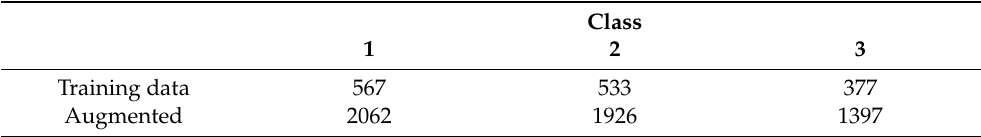
Figure 1. Representative examples of mammograms in MLO projection illustrating the 3 defined classes: ( 1 ) “breast tissue”, ( 2 ) “benign lymph nodes”, and ( 3 ) “suspicious lymph nodes”, with magnification of the ROI. Table 1. Number of mammograms used for training and validation of the dCNN, including number after data augmentation.